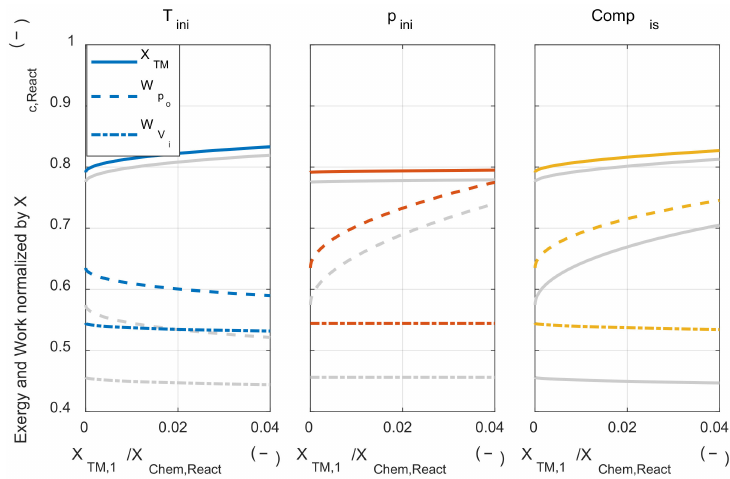
Figure 11. The exergy conversion, the system’s net work, and work that is obtained by expanding to the initial volume under increased compression